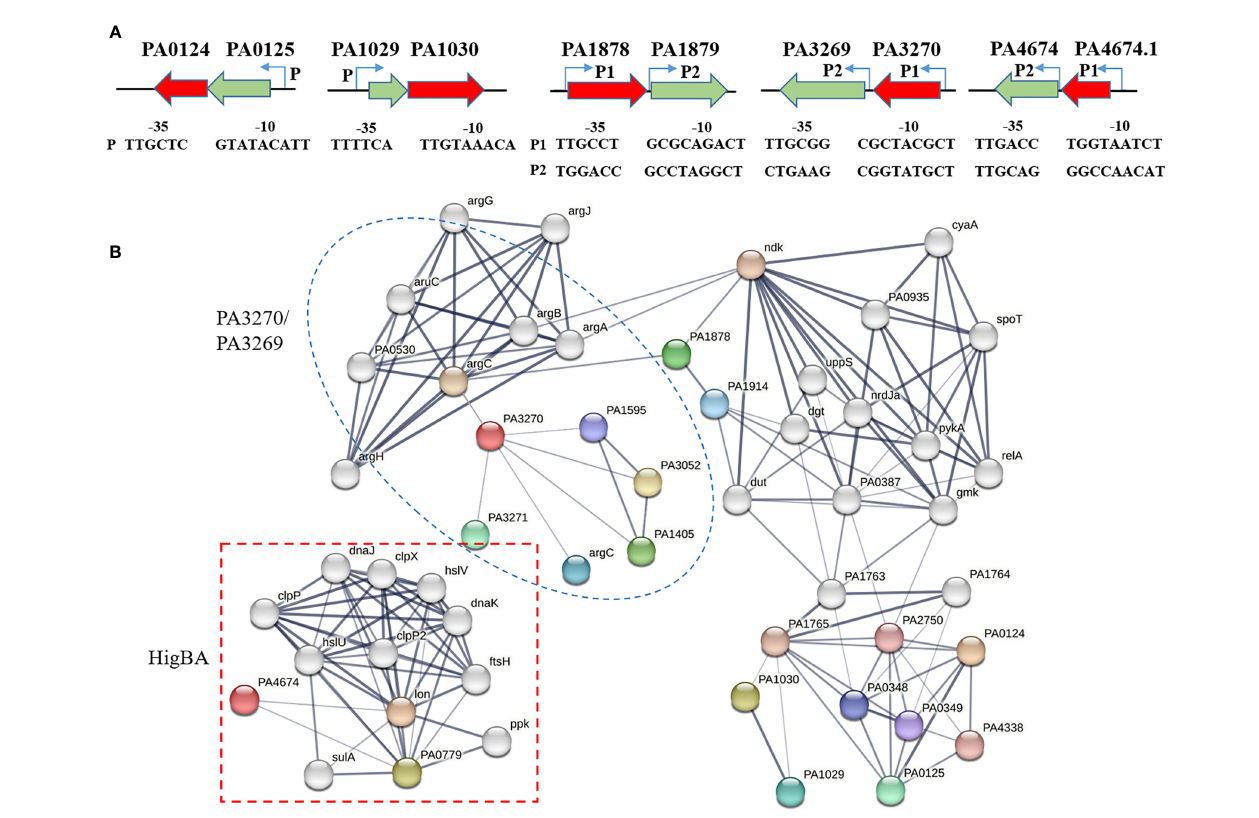
FIGURE 1 Genomic loci and link network of type II TA genes. (A) The operons of type II TA systems and relative promoters. The putative – 35 and – 10 regions of the two promoters are predicted by using Softberry online programs (http://linux1.softberry.com/) and underlined. (B) Network showing the interactions between toxin and other proteins, available in the STRING database. The parameter of interactive relationships among DEGs was set as high con fi dence >